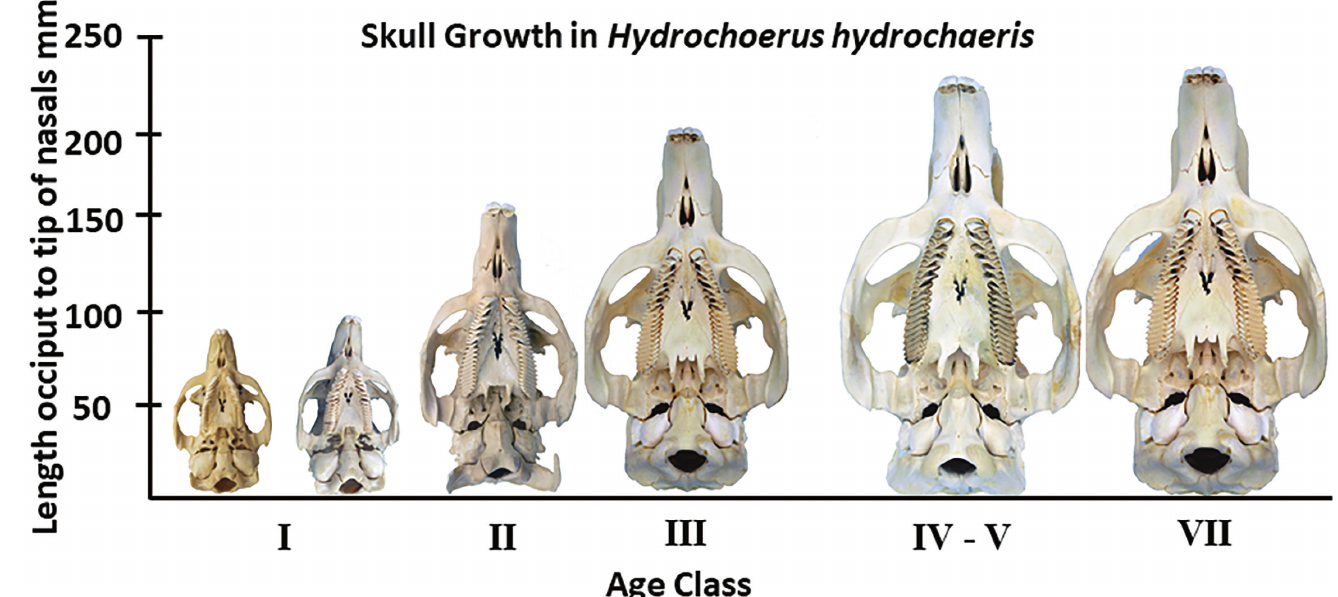
Figure 8. Skull growth in Hydrochoerus hydrochaeris . Specimens are, from left to right: MSCC 456, MSCC 457, MSCC 463, MSCC 461, MSCC 462, MSCC 460.